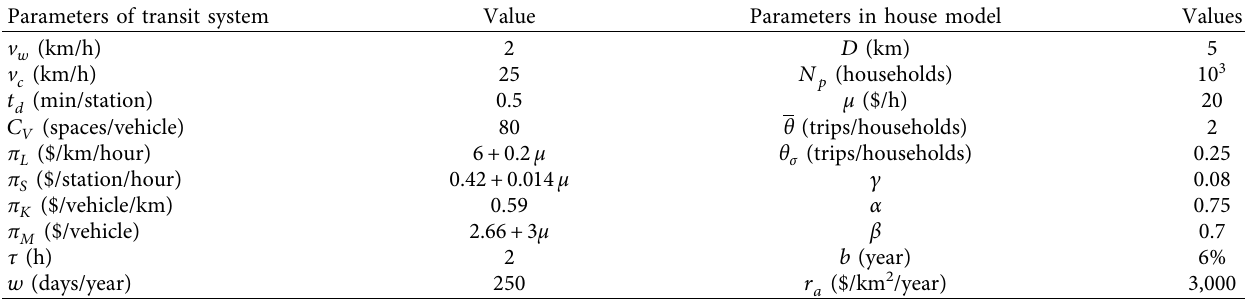
Table 2: Parameter values in the numerical experiment.